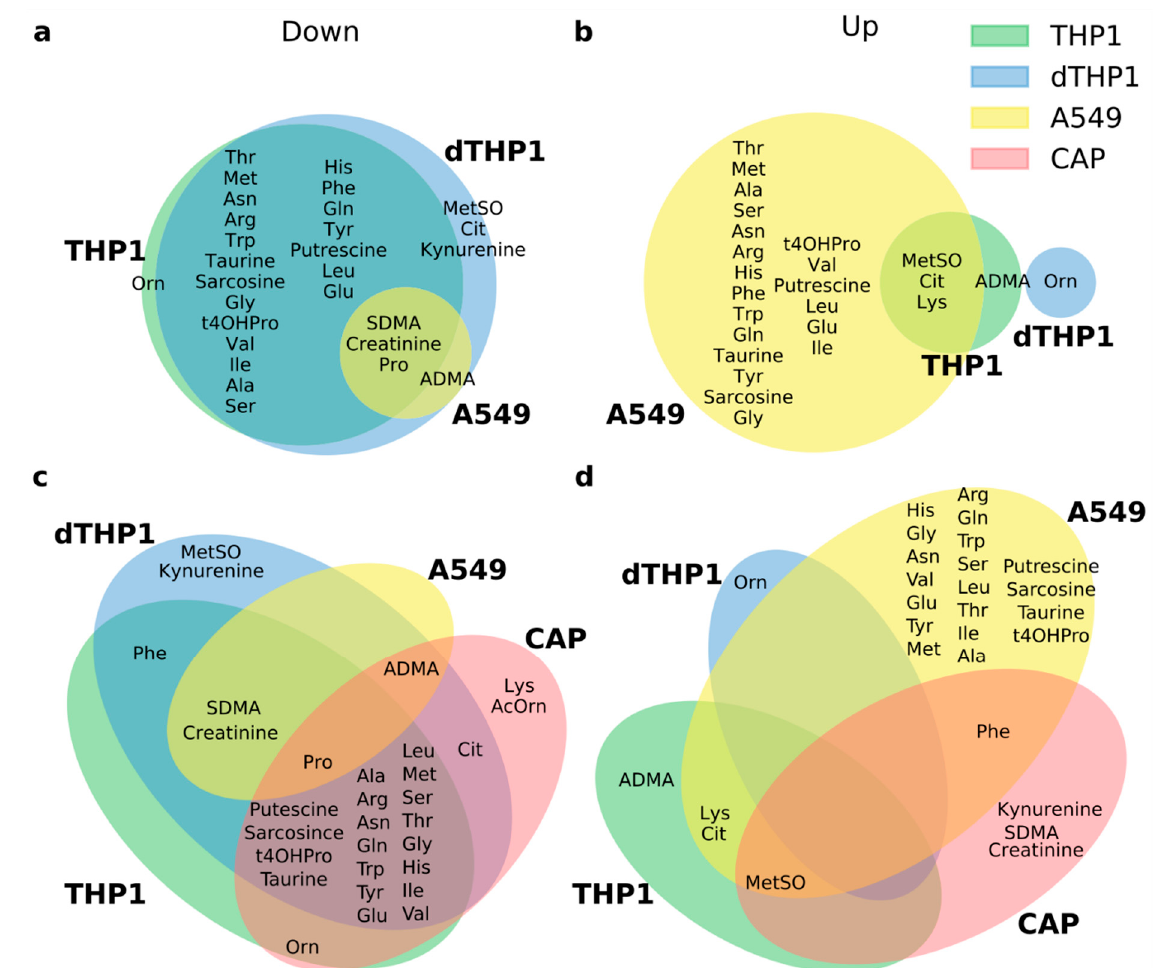
Figure 3. Common and distinct features of changes in amino acid metabolism: comparison of acute CAP with three human cell lines infected with S. aureus . A549, THP1, and PMA- differentiated THP1 (dTHP1) cells were infected with S. aureus strain SH1000 at an MOI of 25, harvested 2 h post infection, and analyte concentrations in cells were measured with the same targeted metabolomic assay as used for the plasma samples. Shared and common differentially abundant (FDR ≤ 0.05) analyte subpopulations are defined by the intersects of the circles/ovals in the Venn diagrams. ( a , b ) S. aureus -infected cell lines. ( c , d ) acute CAP and S. aureus -infected cell lines. The analyte abbreviations are defined in Table S2.